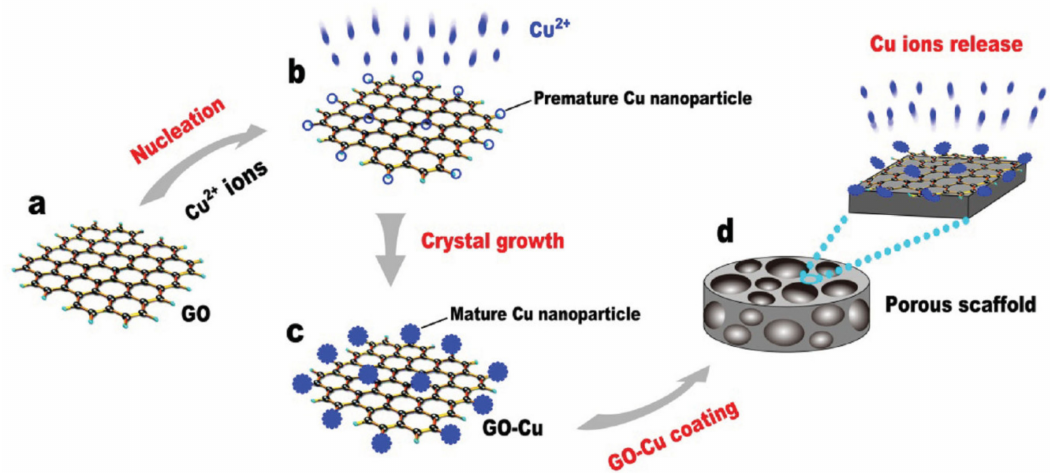
Figure 1. Schematic of the experimental protocol followed for the fabrication of GO-Cu-coated CPC scaffolds. ( a ) The GO pattern; ( b ) Premature Cu nanoparticles on GO films; ( c ) Mature nanoparticles on GO films; and ( d ) GO-Cu coated porous CPC scaffolds. Reproduced from [40], with permission of WILEY-VCH